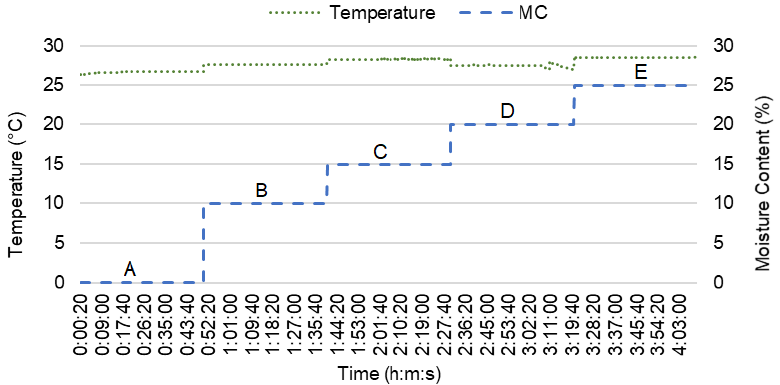
Figure 4. The temperature during testing.